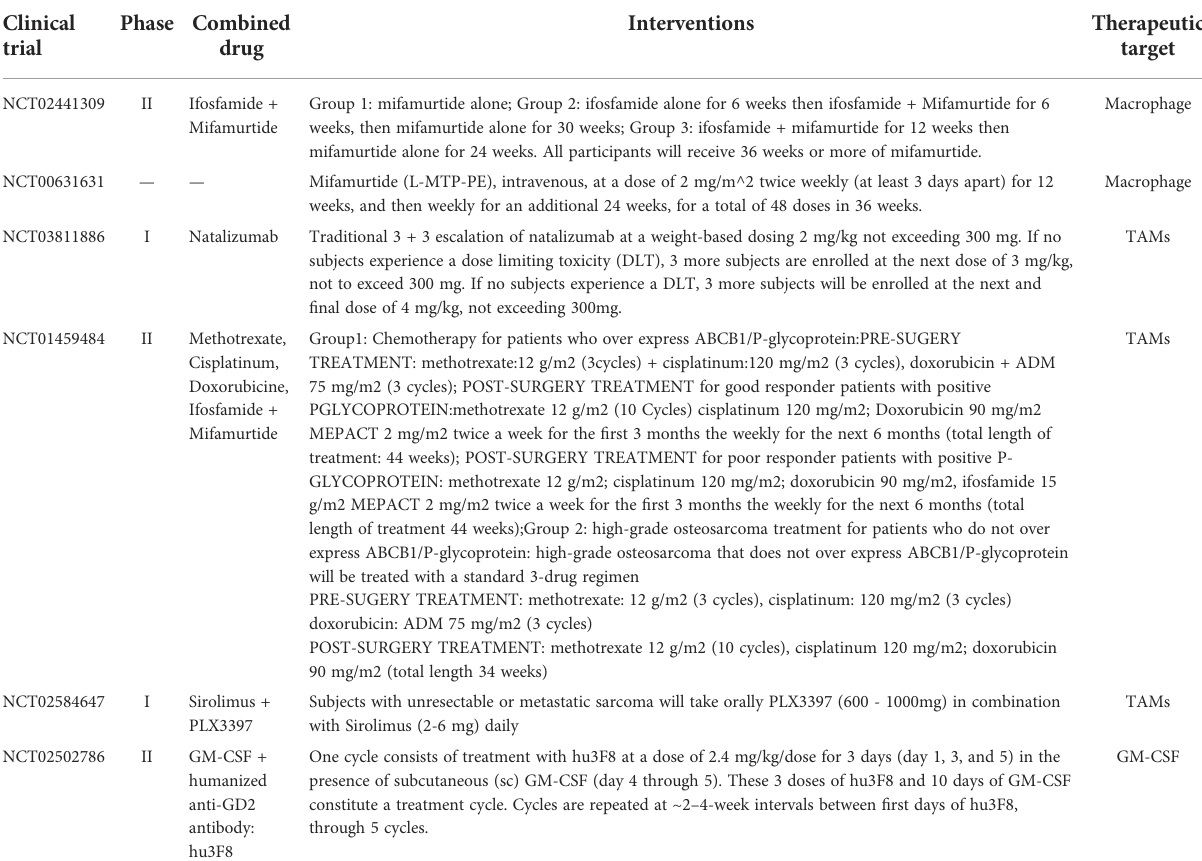
TABLE 3 Schematic diagram of progressive clinical trials on OS TAM-centered treatments. Clinical